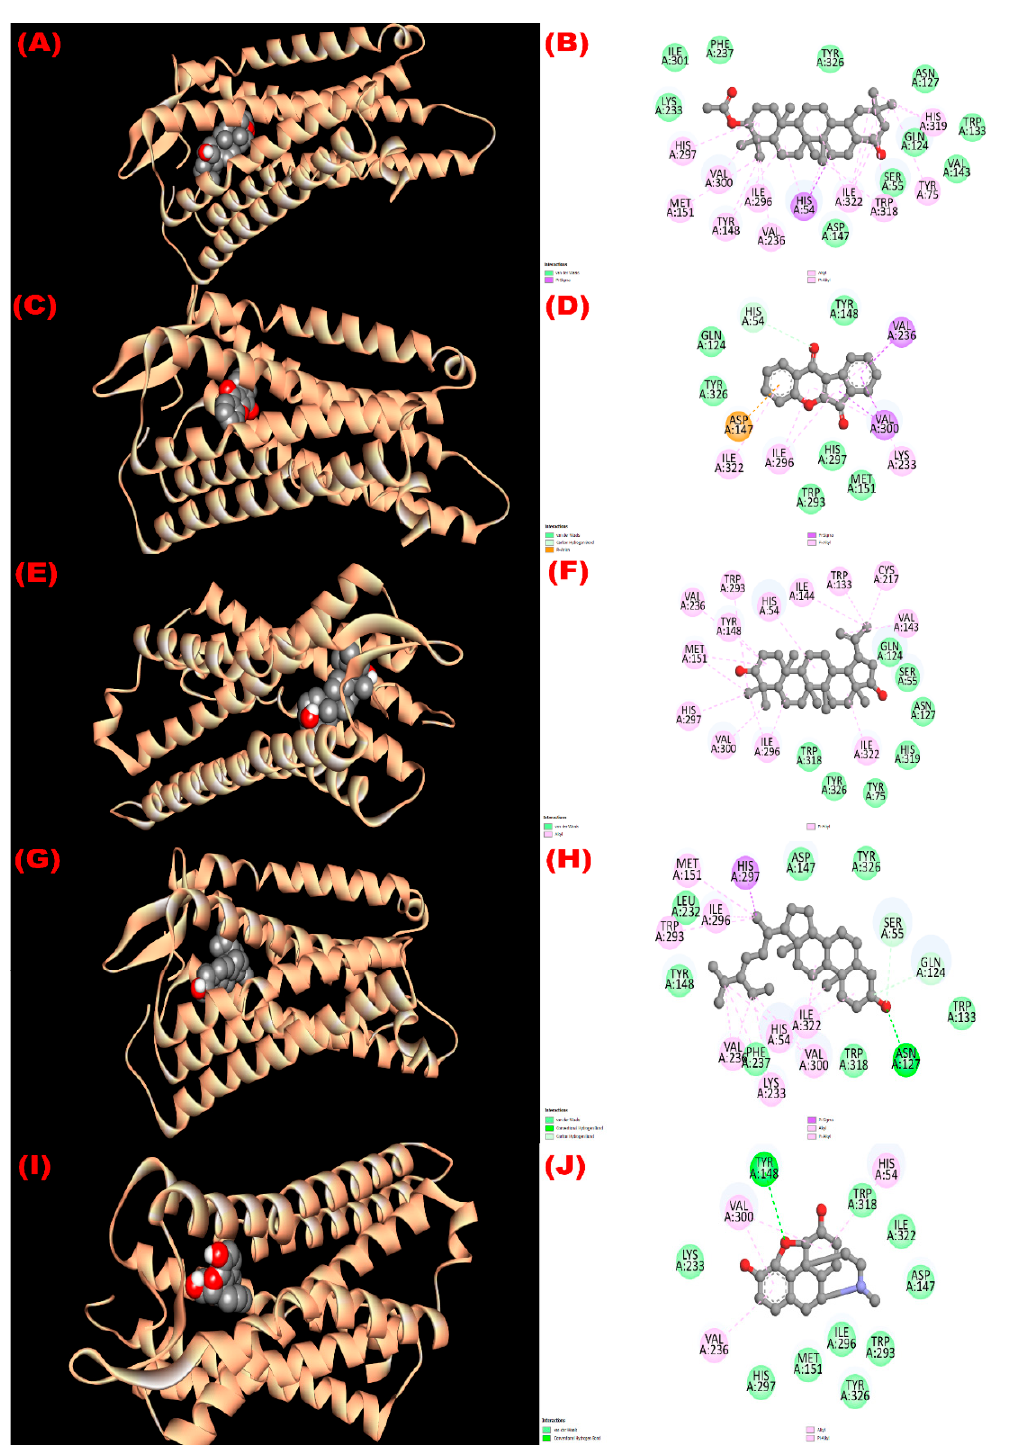
Figure 6. The 3D and 2D view of molecular interactions of the isolated compounds with the Mu- opioid receptor (PDB ID: 5C1M) revealing the central analgesic activity. (( A , B ), ( C , D ), ( E , F ), ( G , H ), ( I , J ) sketched the pictorial view of molecular interactions of compounds ( 1–4 ) 3 β -acetyloxy-olean-12-en-28-ol, wrightiadione, 22 β -hydroxylupeol, β -sitosterol, and the standard morphine, respec- tively).